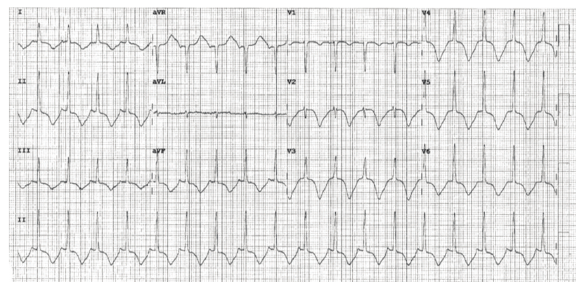
Figure 1: ECG on admission showing marked QT prolongation of 640millisecondsandgiant T- waveinversionsinallleadsexceptAVR and